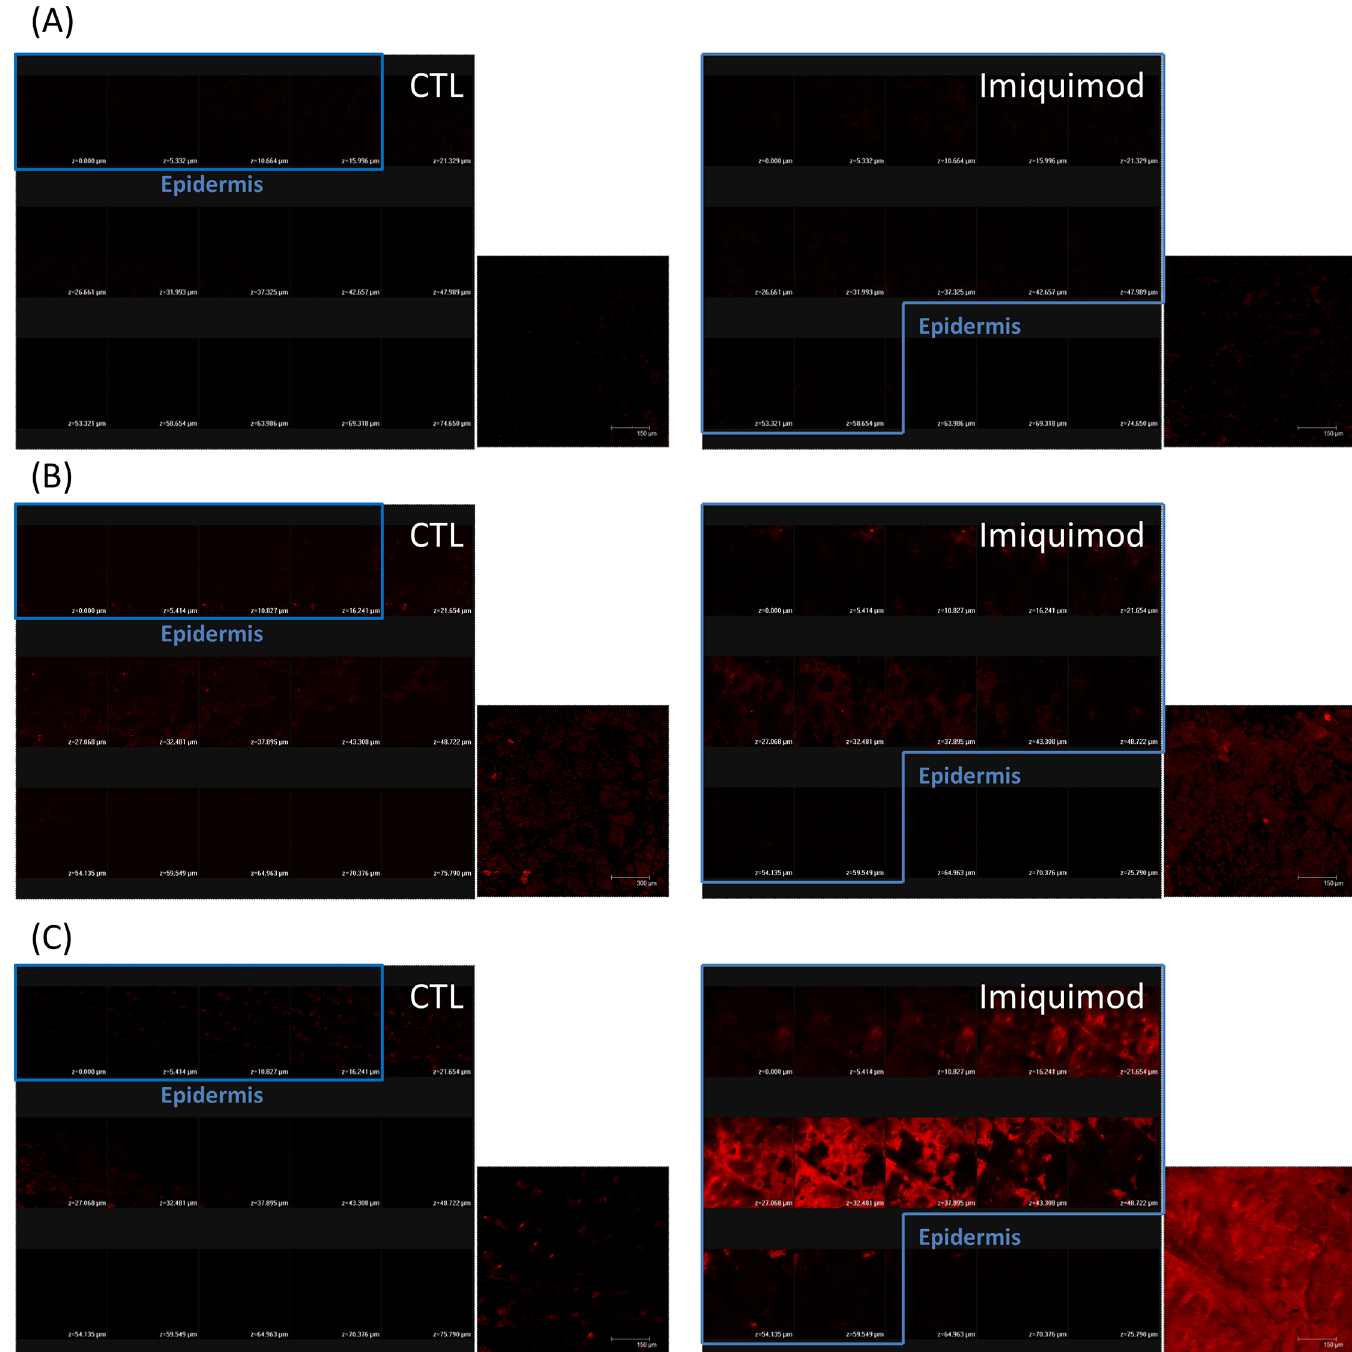
Fig 5. Confocal micrographs of mouse skin treated with and without imiquimod cream: (A) the skin without topical application of permeants; (B) the skin topically applied with ALA; and (C) the skin topically applied with rhodamine B. The control group corresponds to the mice treated with the vehicle. Both the fragments from skin surface to the depth of 75 μ m and a summary of 15 fragments at various skin depths are displayed in this figure. Scale bar = 150 μ m.